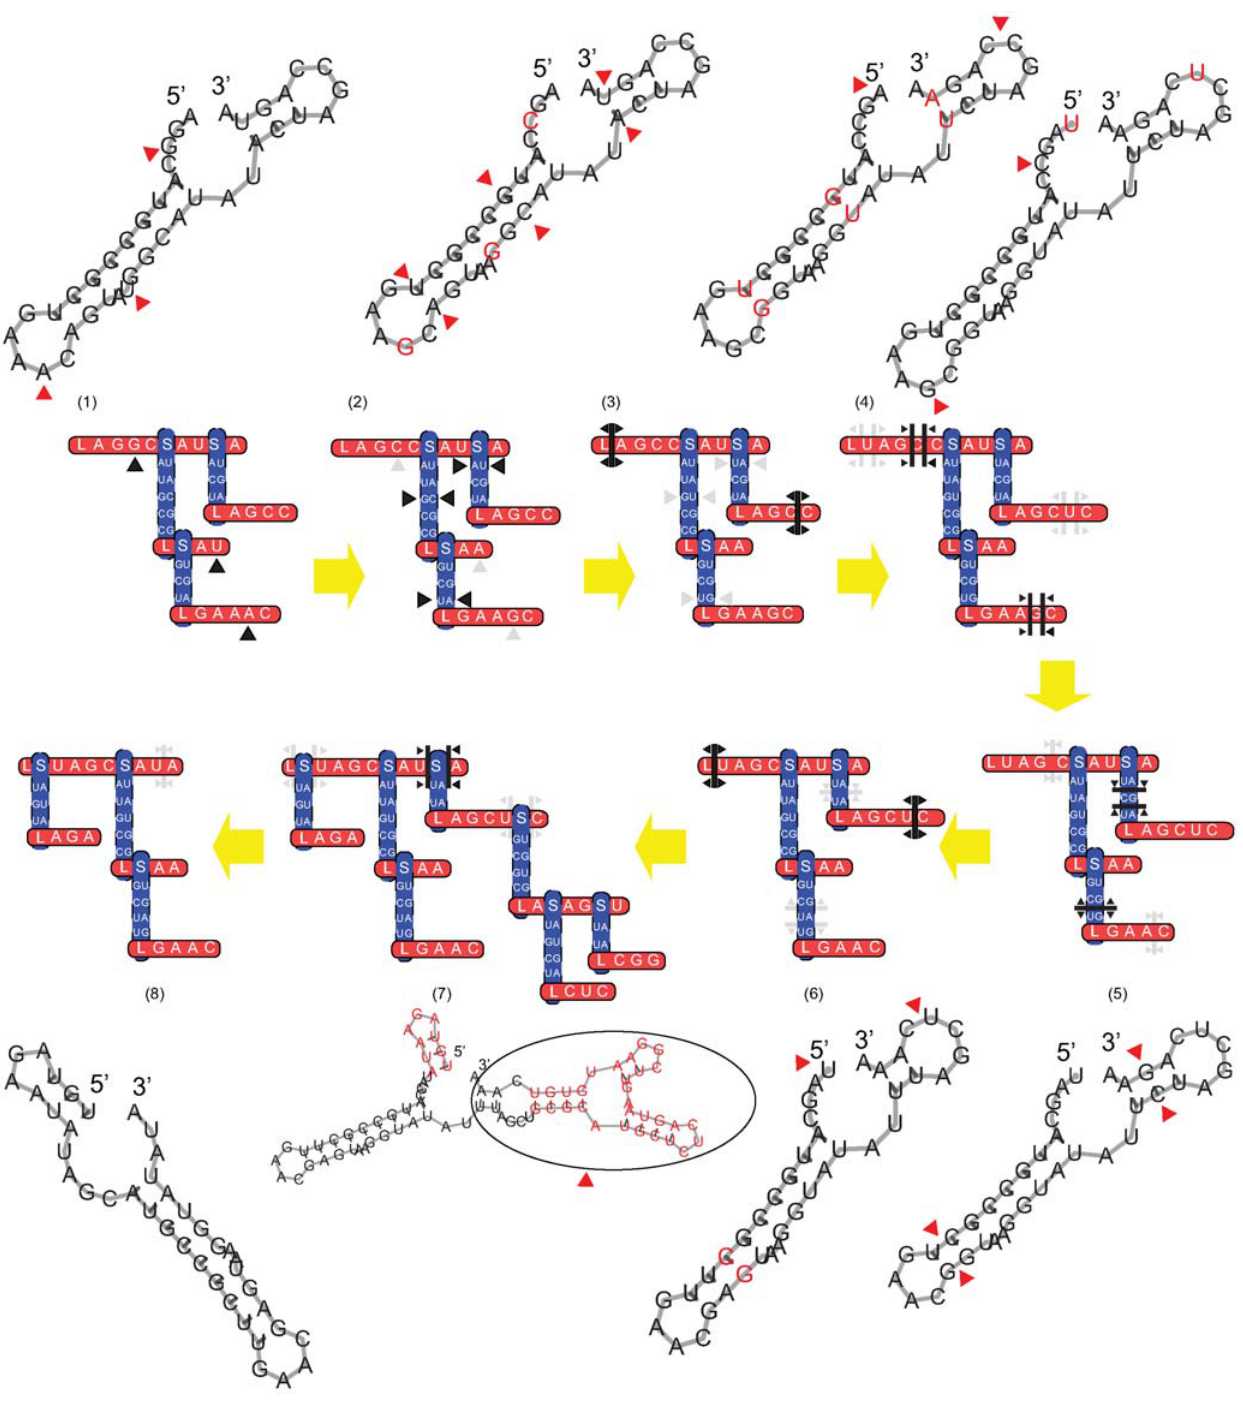
Figure 9. Evolution of a RNA structure under the TKF Structure Tree model. The TKF Structure Tree model includes phenomena such as point mutations in loop sequences ( 1 ? 2 and 4 ? 5 ), covariant mutations in stem sequences ( 2 ? 3 ), insertions in loop sequences ( 3 ? 4 ), insertions in stem sequences ( 5 ? 6 ), structural insertions ( 6 ? 7 ), and structural deletions ( 7 ? 8 ). Figure is extended from a similar version in [29].